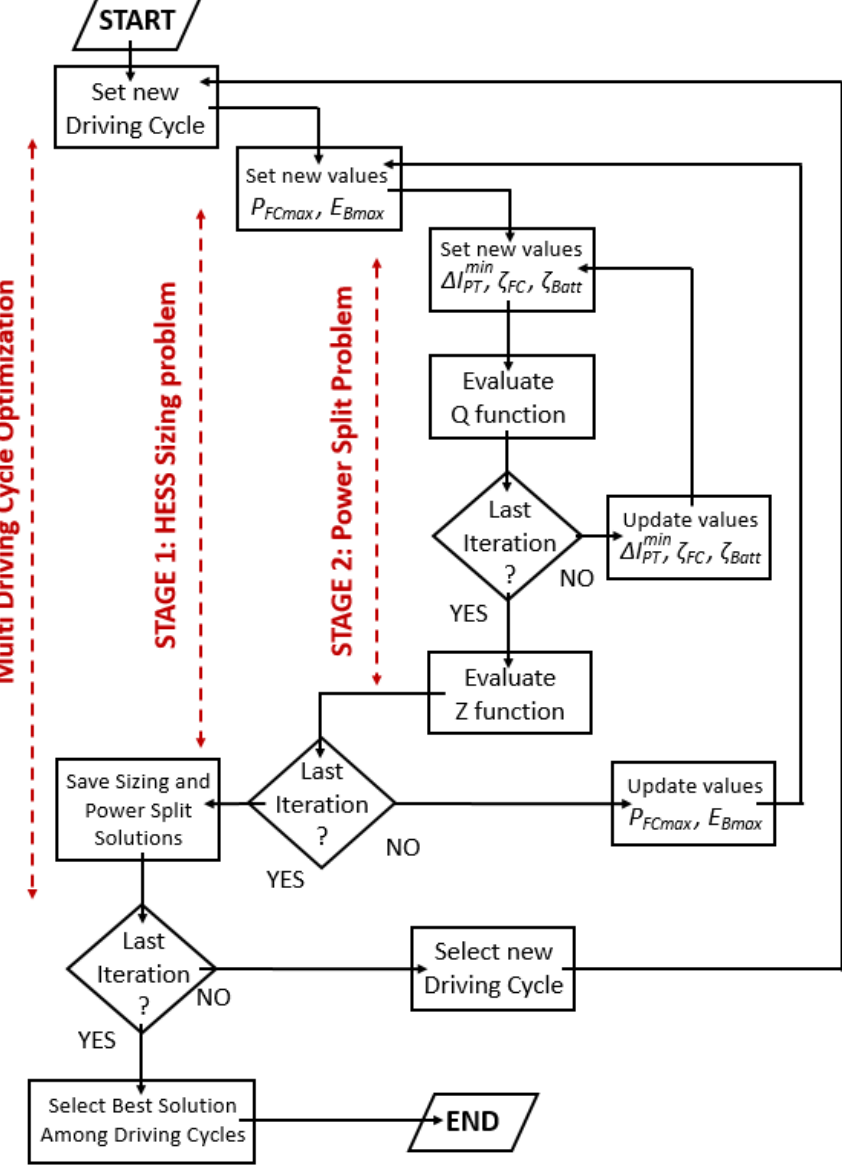
Figure 9. Block diagram of the H-ESS sizing procedure, including the power split strategy.